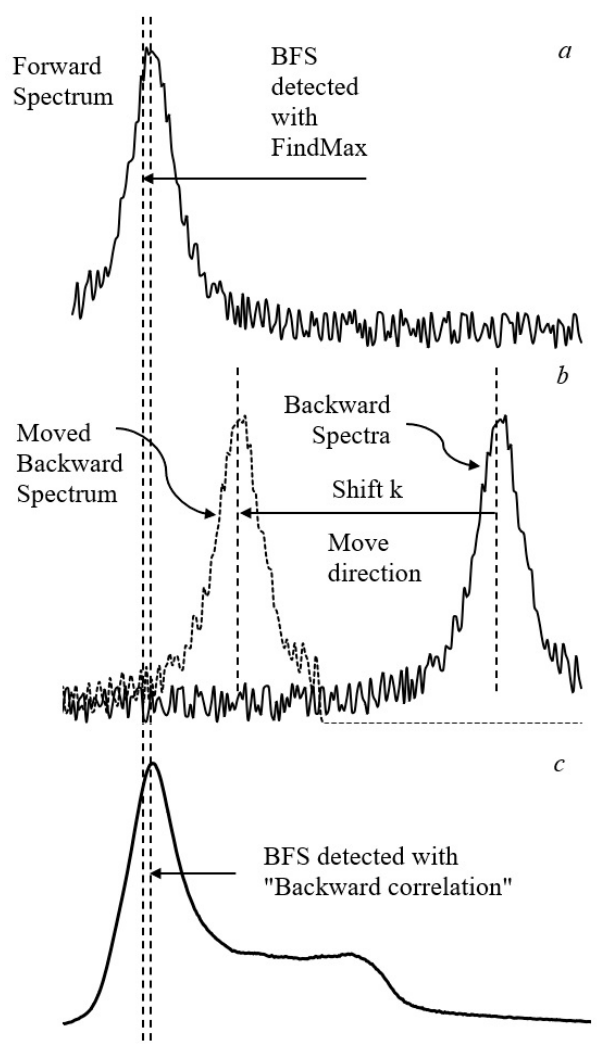
Figure 1. A schematic diagram combined using real data, describing the new method operation principle: ( a ) forward spectrum with Brillouin frequency shift (BFS) detected using FindMax procedure; ( b ) backward spectrum with its shifted copy; and ( c ) backward correlation function with its BFS.